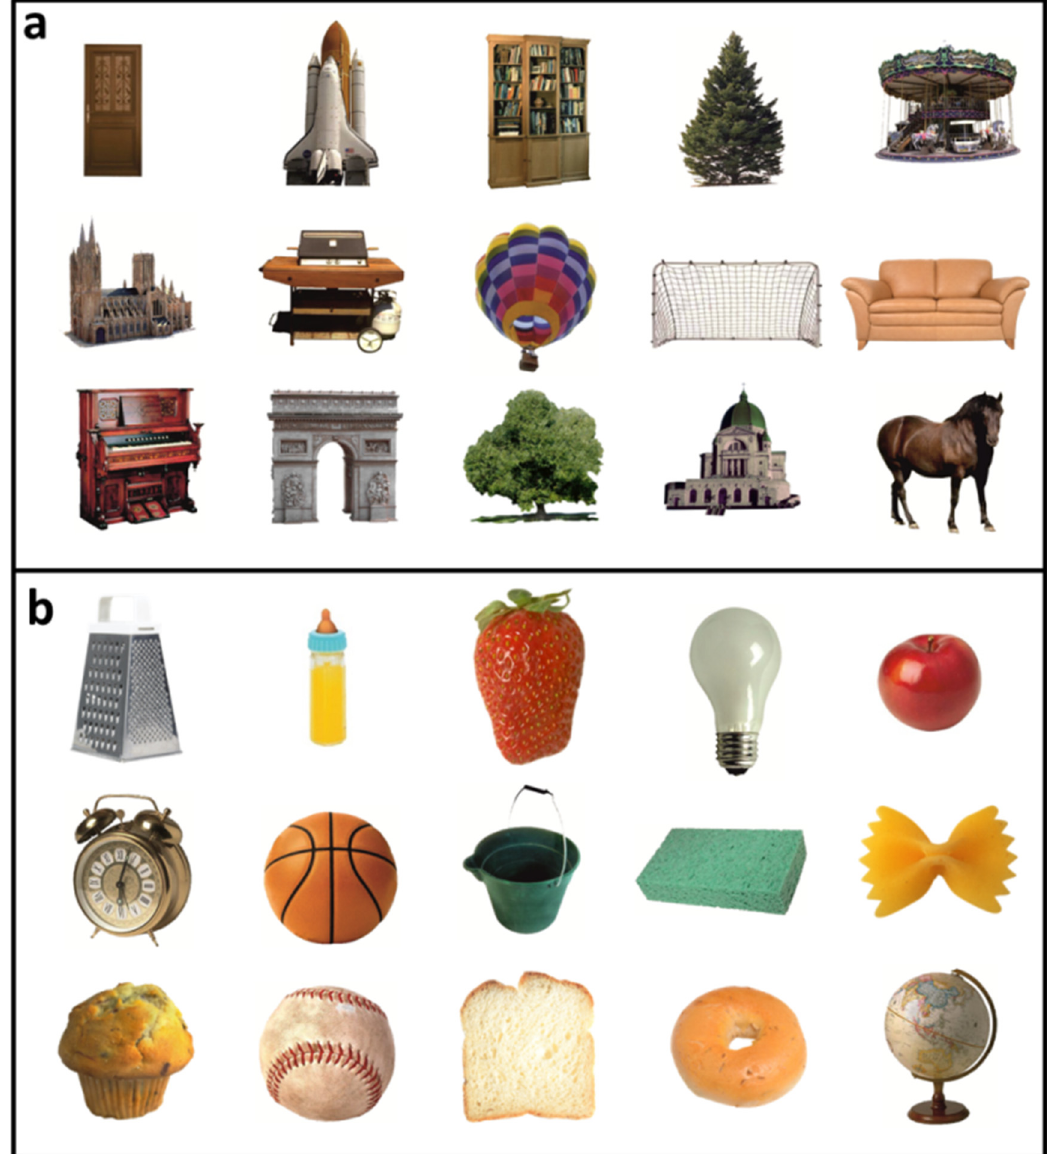
Figure 1. Overview of the stimuli used in the current experiment. Stimuli used in the current study were all made up of objects with either large ( a ) or small ( b ) real-world size as ranked by subjects in a study by [5].